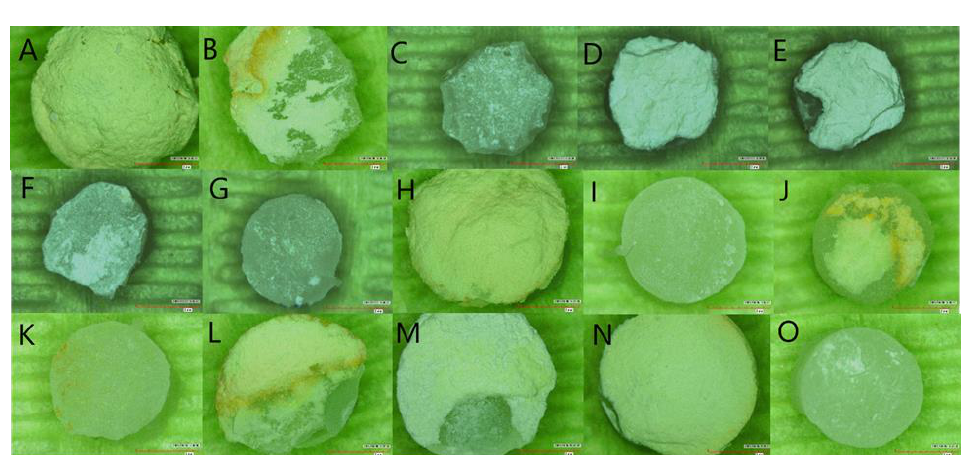
Figure 2. Photographs of samples representing fracture mode under Digital Microscope at 40× mag- nification. ( A ) NeoMTA2 cohesive fracture. ( B ) NeoMTA2 Mixed fracture. ( C ) NeoMTA2 adhesive fracture. ( D ) NeoPUTTY cohesive fracture. ( E ) NeoPUTTY mixed fracture. ( F ) NeoPUTTY mixed fracture. ( G ) NeoPUTTY adhesive. ( H ) ProRootMTA cohesive fracture. ( I ) ProRootMTA adhesive fracture. ( J ) ProRootMTA mixed fracture. ( K ) ProRootMTA adhesive fracture. ( L ) ProRootMTA mixed fracture. ( M ) TotalFill mixed fracture. ( N ) TotalFill cohesive fracture. ( O ) TotalFill